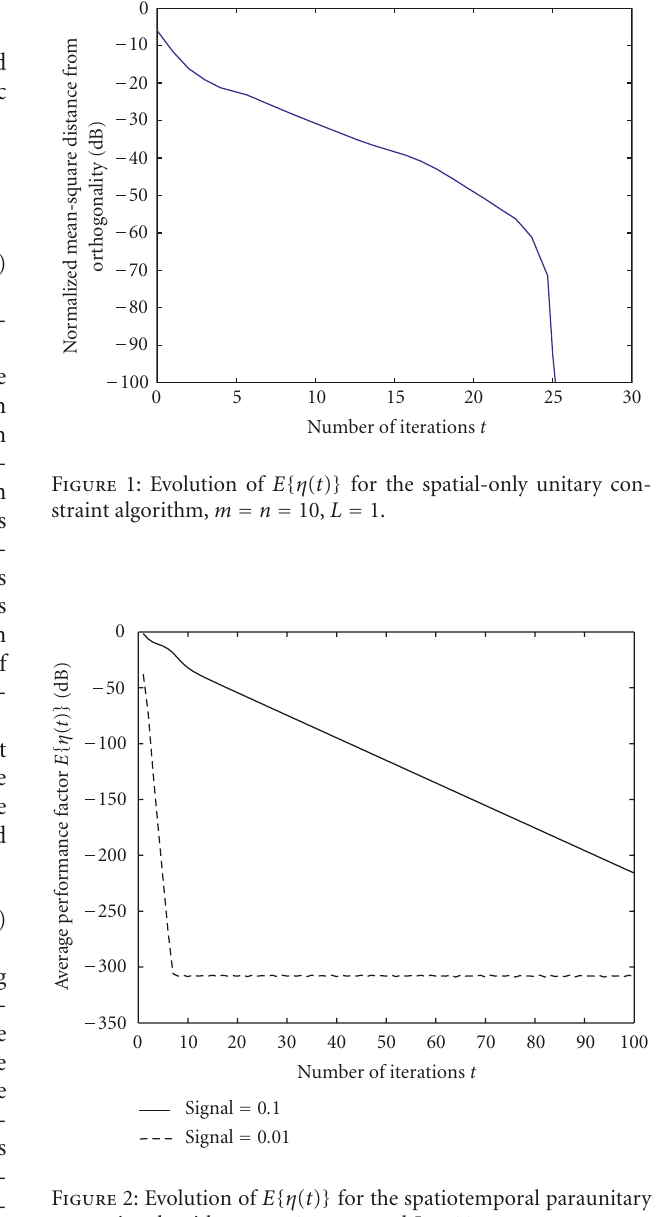
Figure 2: Evolution of E { η ( t ) } for the spatiotemporal paraunitary constraint algorithm, m = 4, n = 7, and L =